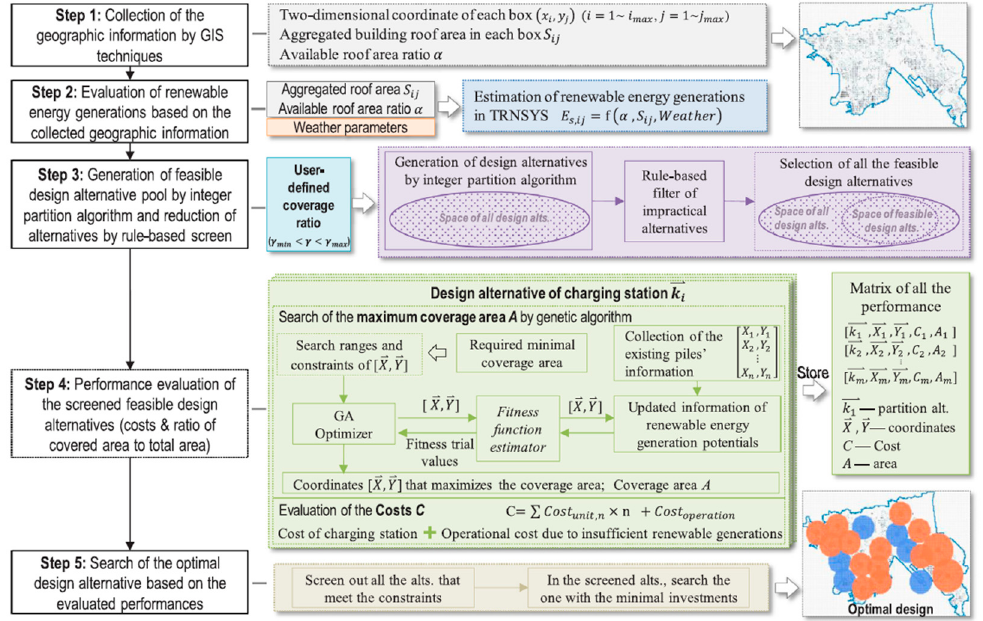
Energies 2023 , 16 , 179 17 of 32